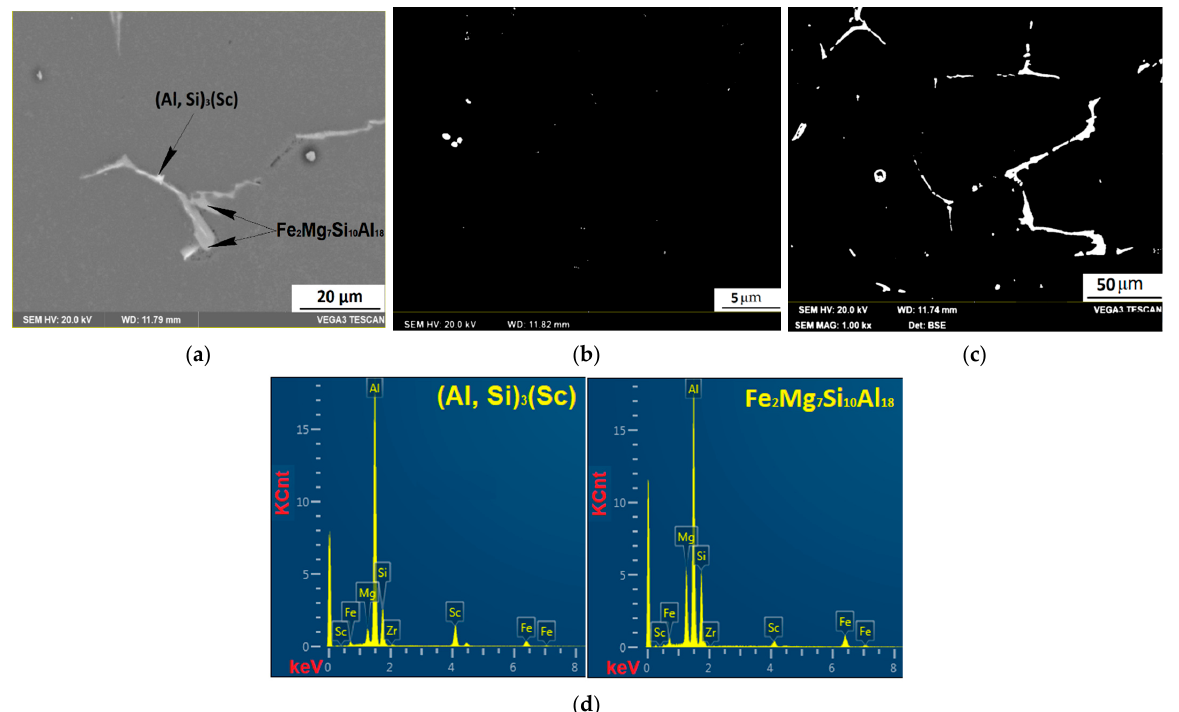
Figure 9. Al 0.5 Mg 1.3 Si 0.3 Sc 0.15 Zr main types of intermetallic compounds ( a ); small dispersoids ( b ); large particles ( c ); result the EDS investigation of chemical composition of the intermetallic compounds ( d ). Table 2. Size and amount of dispersoids in the investigated alloys.